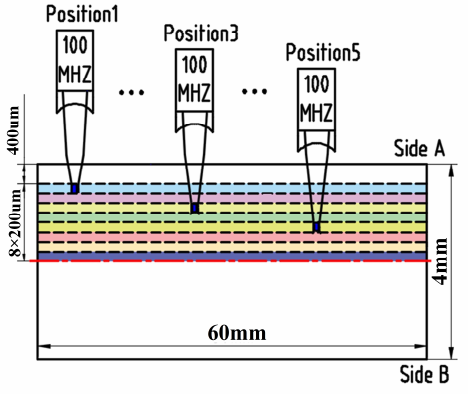
Figure 3. Inspection diagram.